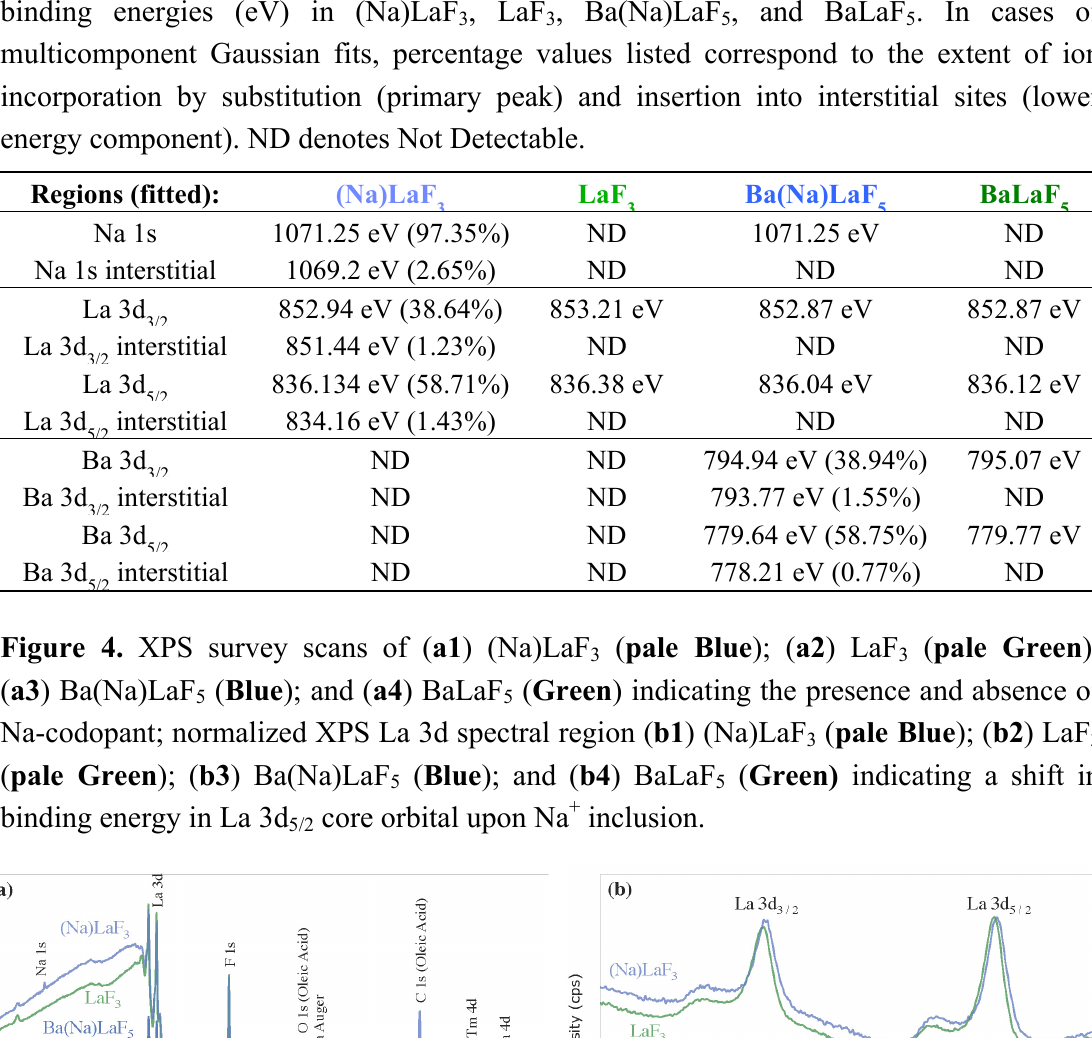
, LaF , Ba(Na)LaF , and BaLaF . In cases of 3 3 5 5